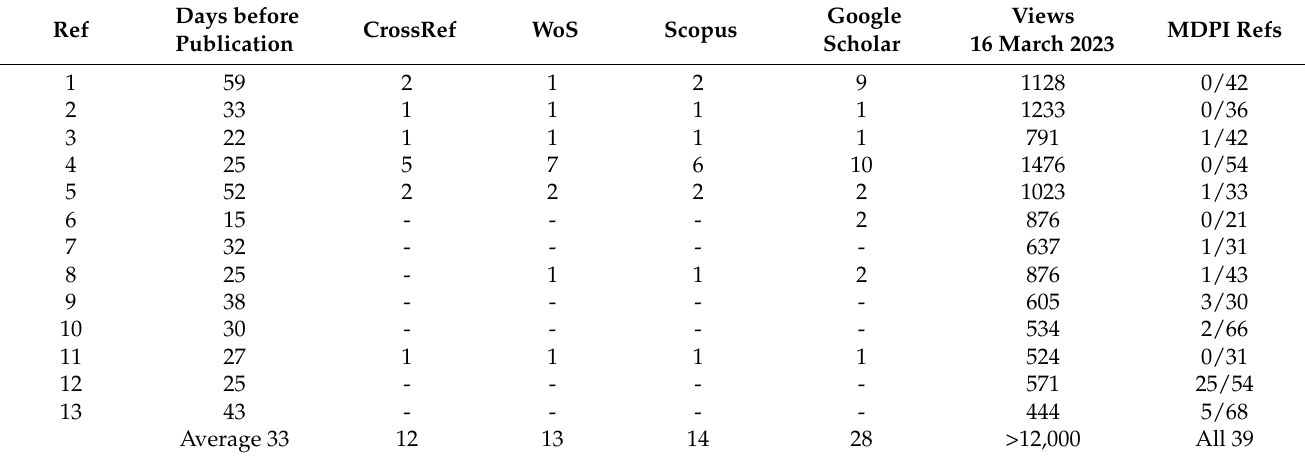
Table 1. Statistics and geography of published papers (27 March